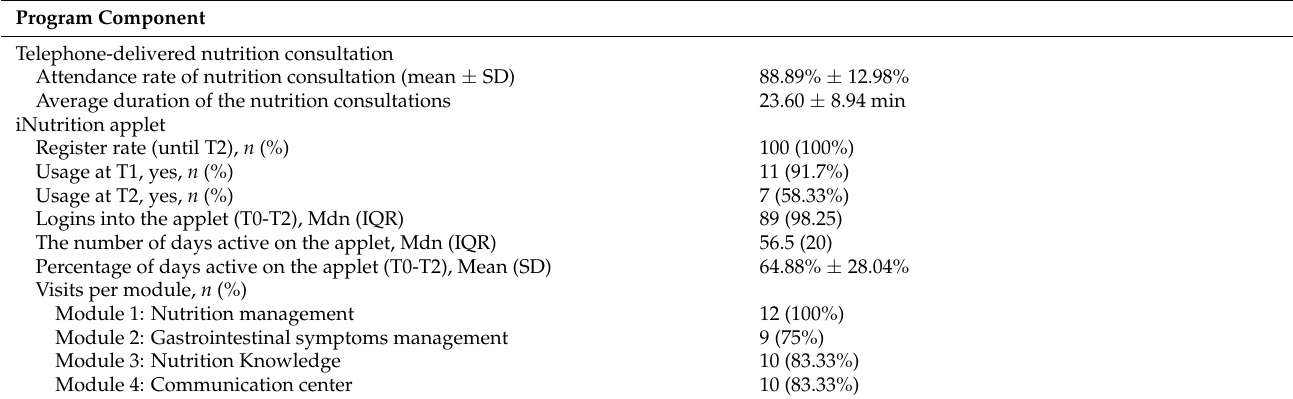
Table 2. Adherence to different program components ( n =